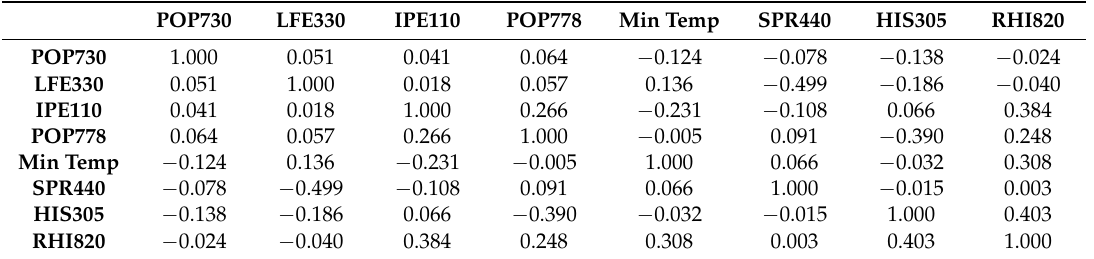
Table 2. Pearson correlation analysis between selected variables for modeling STIR, continental US.